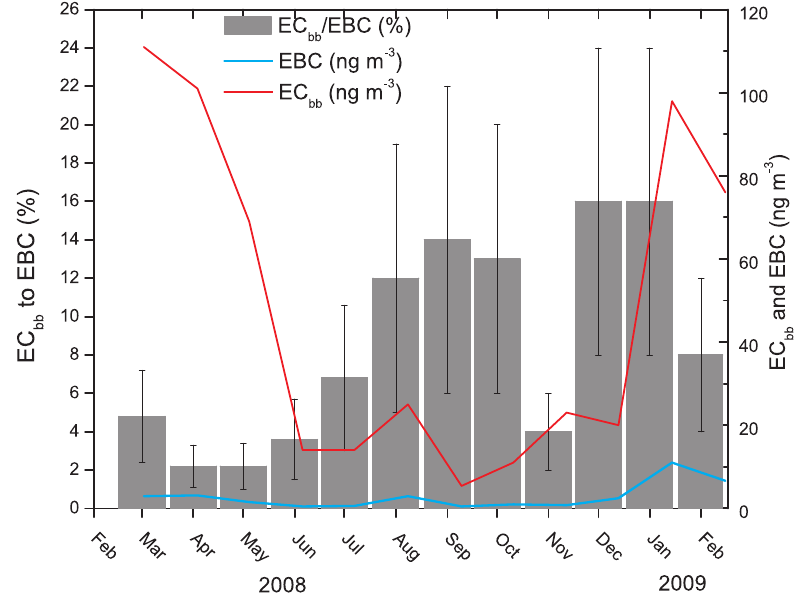
Figure 5. The grey bars show the monthly mean relative contribution of elemental carbon from biomass burning (EC bb ) to total equivalent black carbon (EBC) at Zeppelin for the time period March 2008–February 2009 (left axis). Standard deviations are included. These values are lower estimates as degradation of levoglucosan are not accounted for. The light-blue curve is the monthly mean ambient concentration of elemental carbon from biomass burning (EC bb ), whereas the red curve is that of equivalent black carbon (EBC) for the same period (right